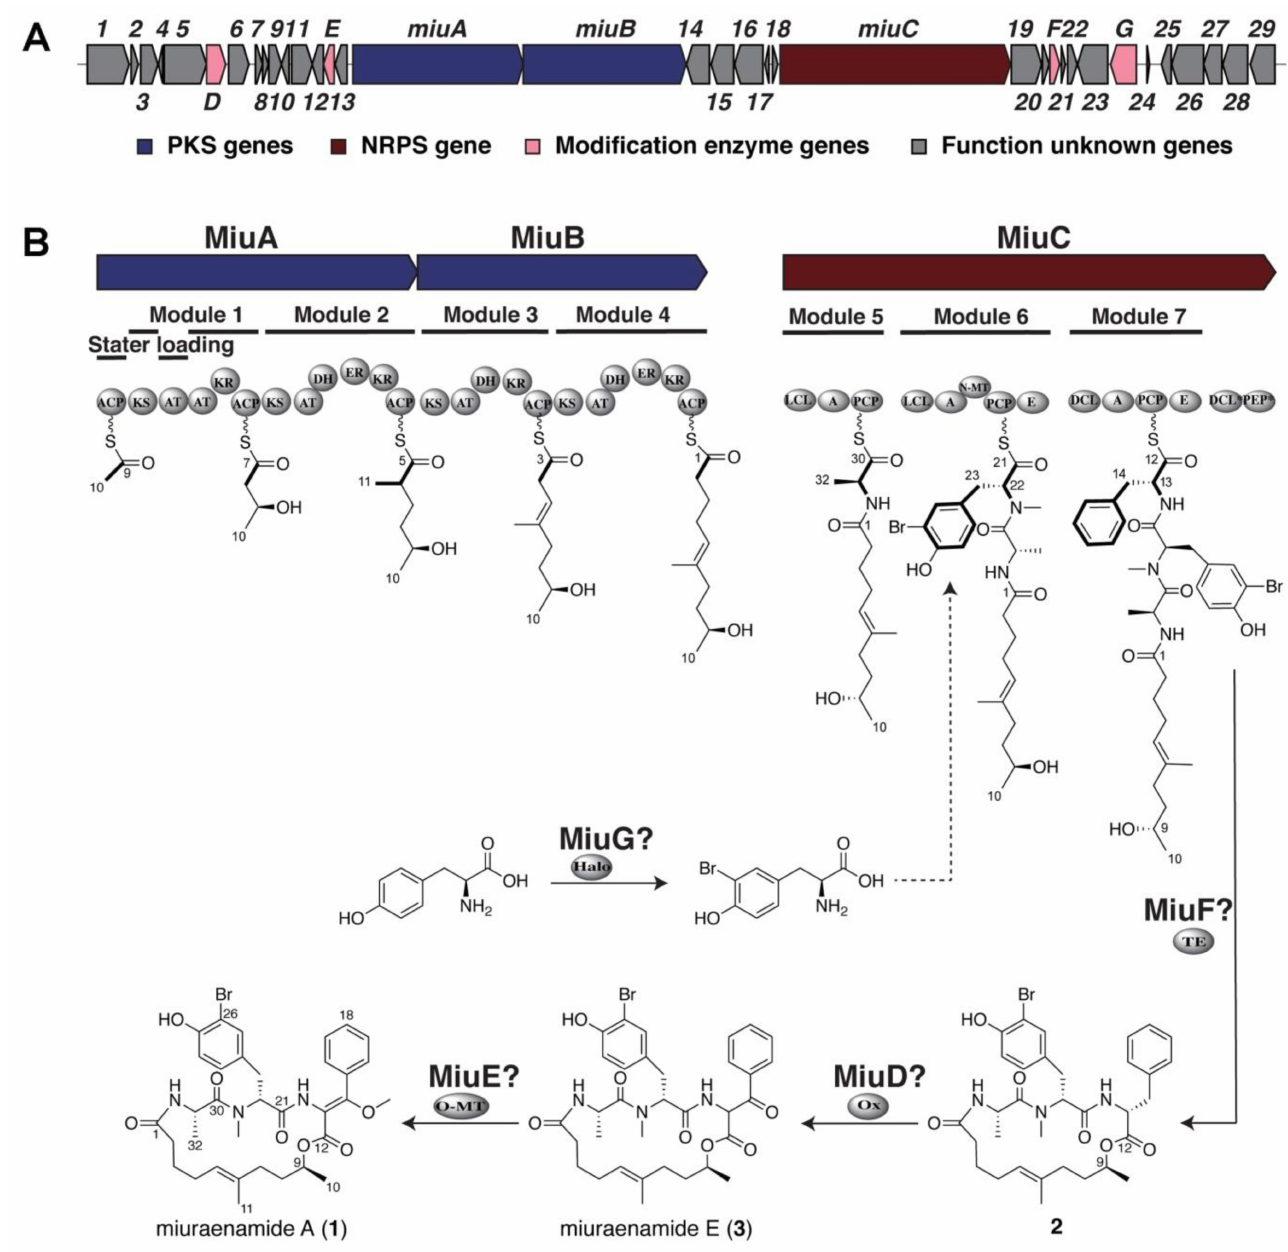
Figure 2. Organization of the miu cluster and proposed biosynthetic pathway for miurae- namide A ( 1 ). ( A ) Map and gene organization of the miu cluster-containing region predicted using antiSMASH. ( B ) Proposed biosynthetic pathway of 1 . Abbreviations: ACP, acyl carrier protein; AT, acyl transferase; DH, β -hydroxy dehydratase; ER, enoyl reductase; KR, β -ketoacyl reductase; KS, ketosynthase; A, adenylation domain; PCP, peptidyl carrier protein; E, epimerization domain; O-MT, O -methyltransferase domain; N-MT, N -methyltransferase domain; LCL, condensation domain that catalyzes the formation of a peptide bond between two L-amino acids; DCL, condensation domain that links an L-amino acid to a growing peptide ending with a D-amino acid; PEP, phospho- enolpyruvate synthase domain; TE, thioesterase; Ox, oxygenase; Halo, halogenase. DCL* and PEP*, DCL and PEP domains unassigned in the proposed biosynthetic